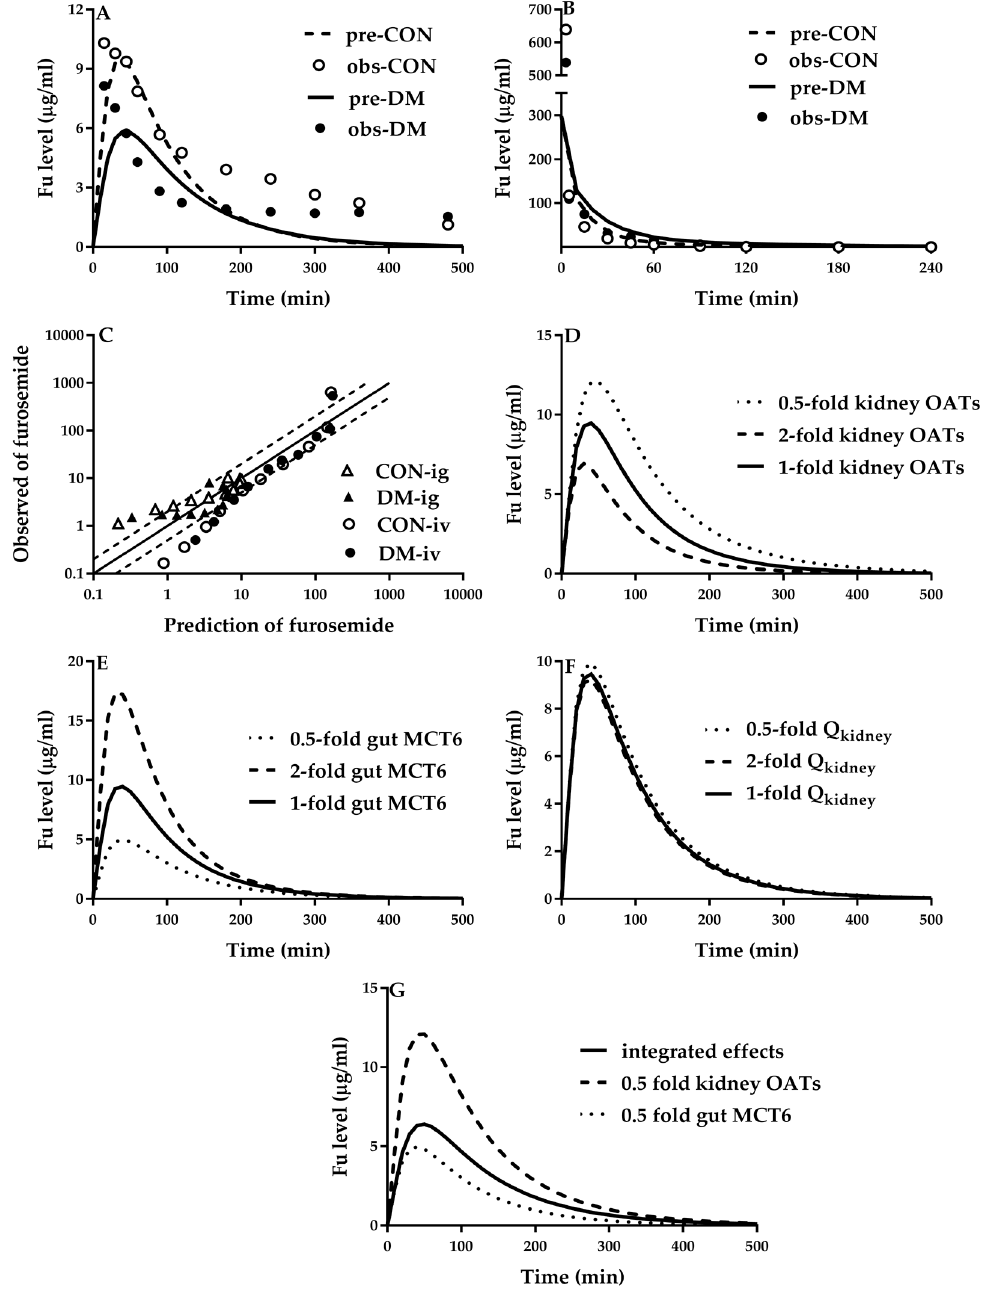
Figure 6. Observed (point) and predicted (line) plasma concentrations of furosemide (Fu) following ( A ) oral (6 mg/rat, ig) and ( B ) intravenous dose (6 mg/rat, iv) to diabetic rats (DM) and control rats (CON). Comparison of mean observed and predicted plasma concentrations of furosemide at each time point ( C ). Contributions of altered ( D ) renal OATs, ( E ) intestinal MCT6 and ( F ) renal blood flow (Q kidney ) to oral plasma exposure of furosemide as well as ( G ) integrated effects of intestinal MCT6 impairment and renal OATs impairment. The observations were obtained from the literature [89].